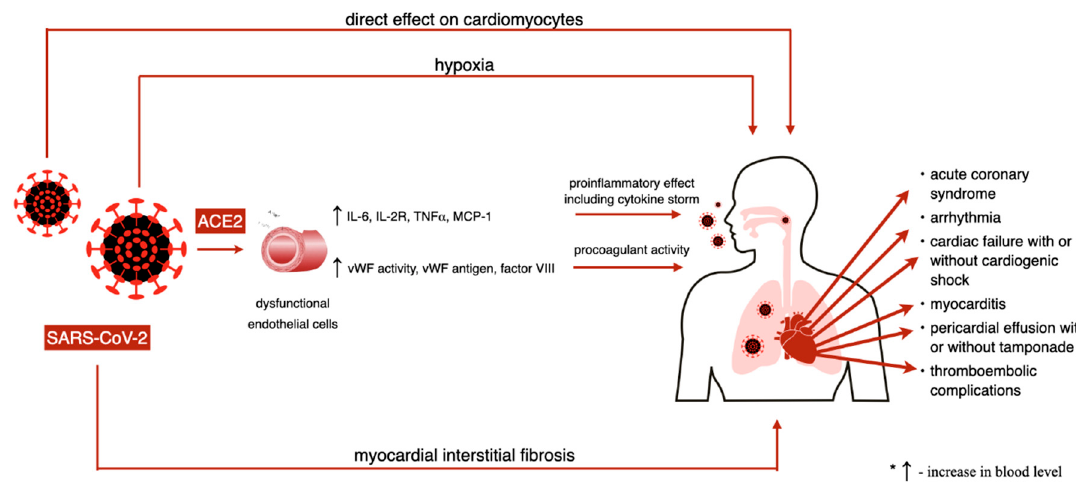
Figure 3. E ff ect of SARS-CoV-2 on cardiovascular